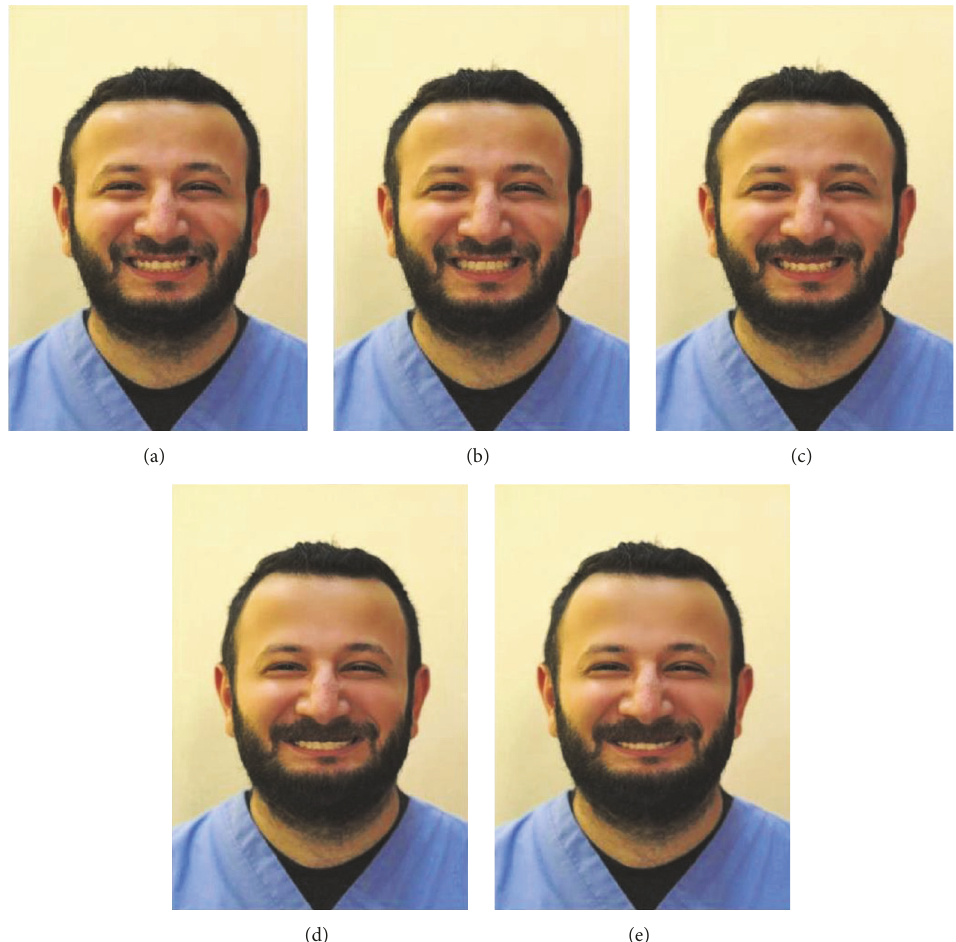
Figure 1: Short face smiles. (a) Short face +2 mm; (b) short face 0 mm; (c) short face +4mm; (d) short face − 2 mm; (e) short face −